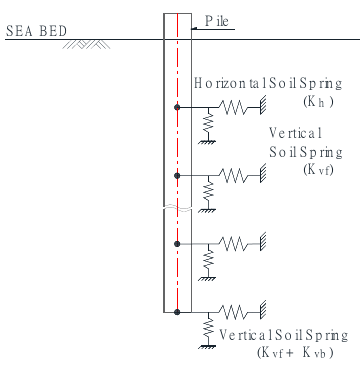
Figure 1. Model for soil springs.